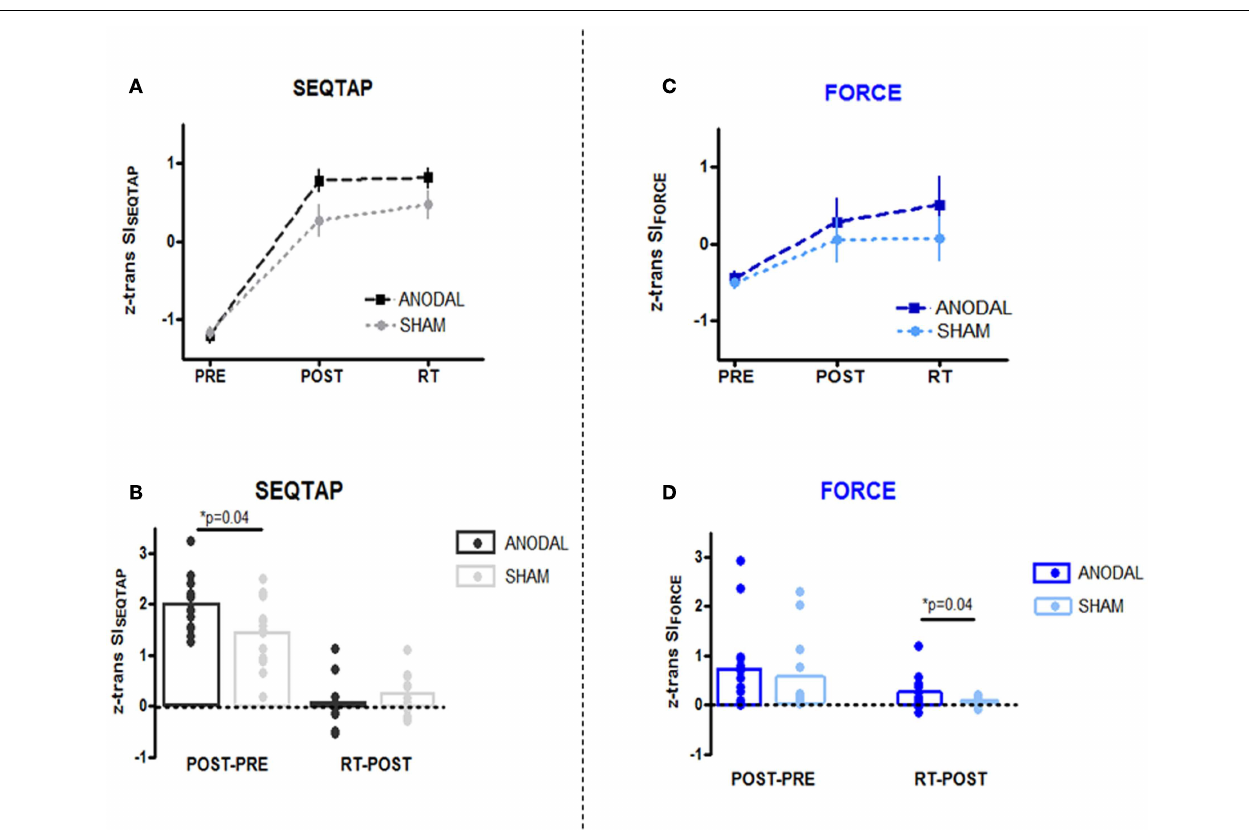
squares/bars) compared with the sham-tDCS (gray circles/bars). (C,D) FORCE data: anodal-tDCS (blue squares/bars) compared with the sham-tDCS (turquoise